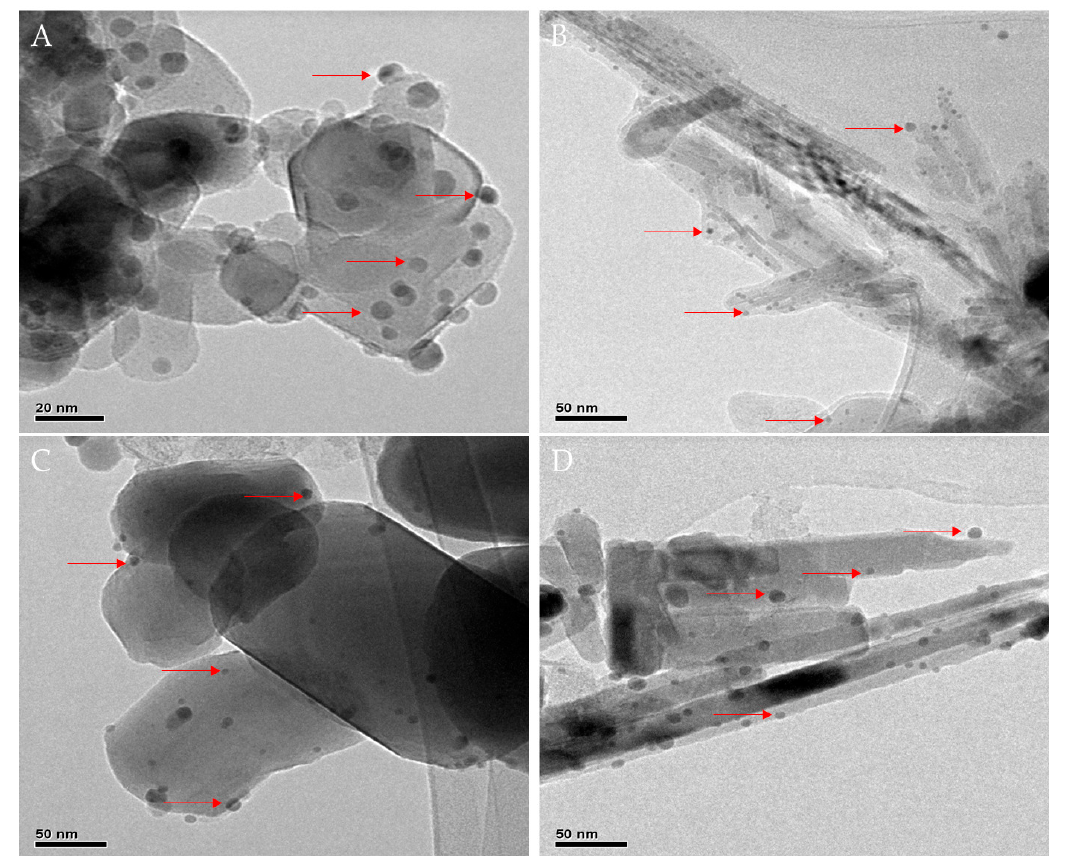
Figure 2. High-resolution transmittance electron microscopy (HRTEM) images of 10%Ag@TiO 2 -P25 ( A ), 10%Ag@TiO 2 NWs ( B ), 10%Ag@ZnO commercial ( C ), and 10%Ag@ZnO NWs ( D ) catalysts. The red arrows indicate the presence of Ag Nanoparticles (NPs).